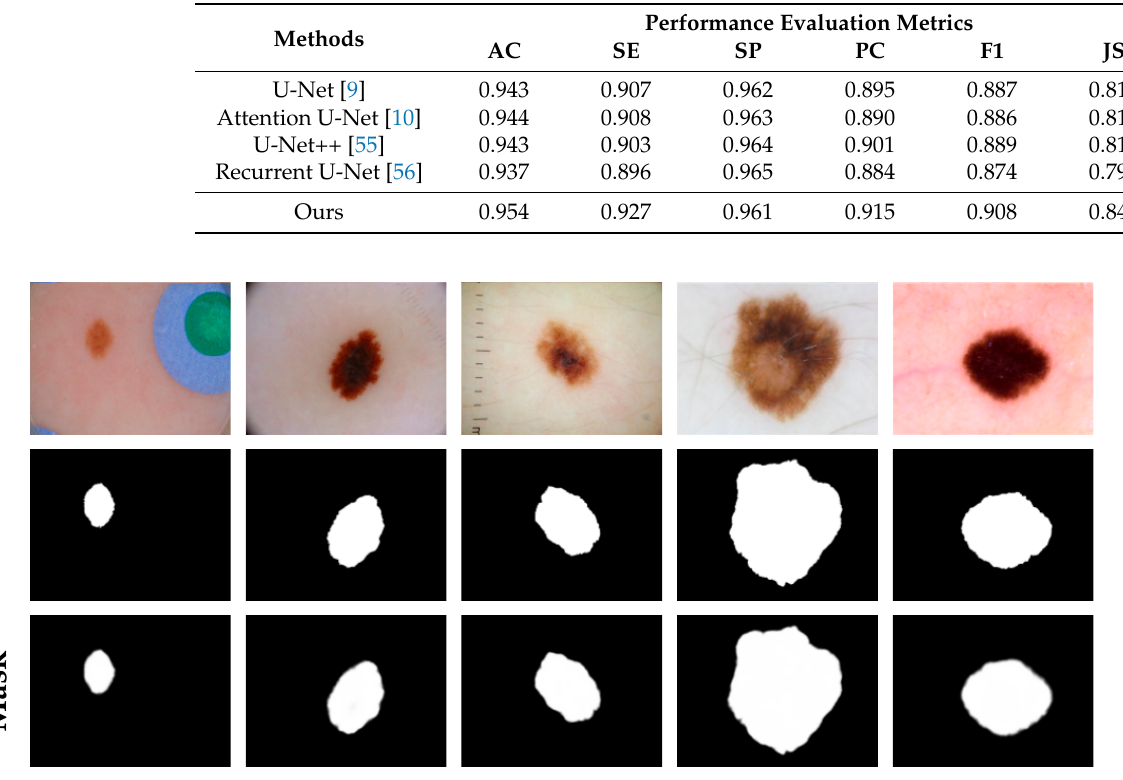
Figure 6. Segmentation results of ASCU-Net on the ISIC-2016 dataset. The first row is the original image. The second row is the skin lesion segmentation ground truth (GT). The third row is the visual segmentation result of the test set of the proposed network.